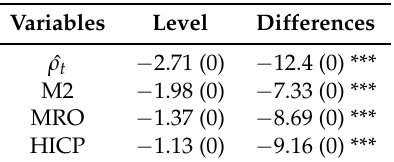
Table A4. Augmented Dickey–Fuller (ADF) test. T-statistics are reported; *** stands for statistical significance at 1%; the appropriate lag length () for ADF test is selected using Schwarz Bayesian criterion (SC).